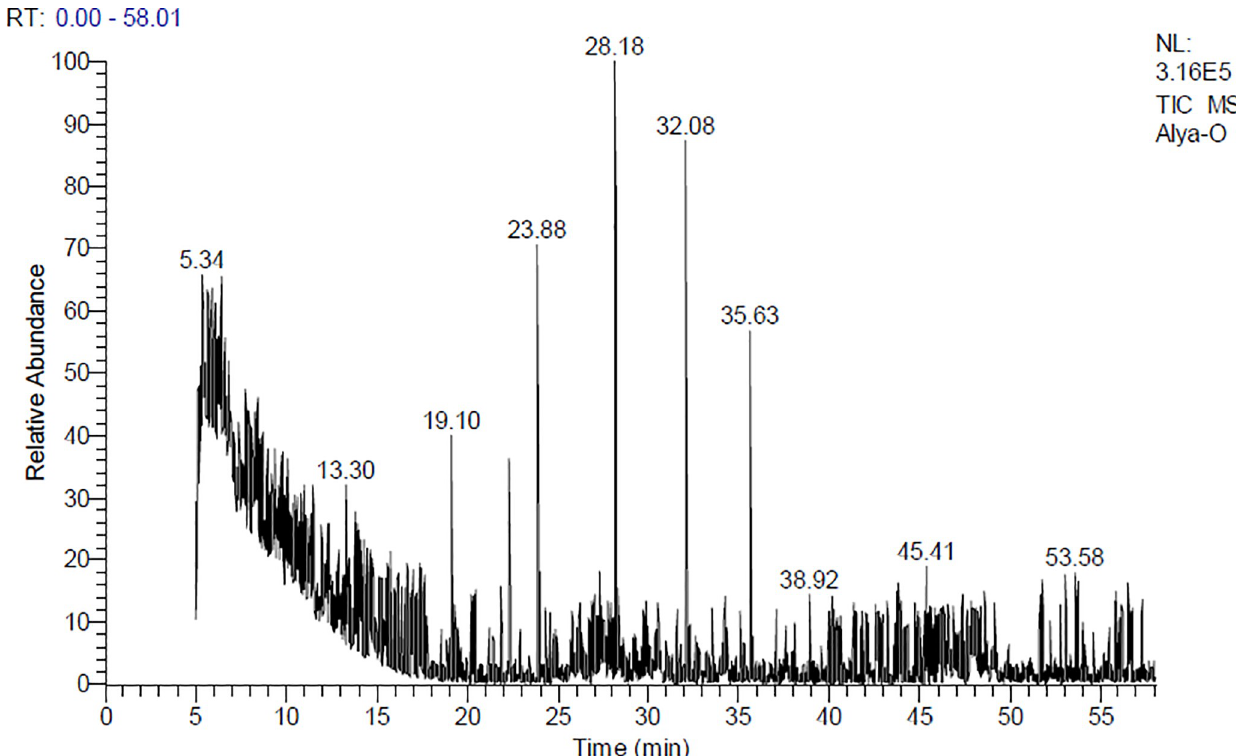
Fig 1. GC-MS chromatogram of RBO analysis.